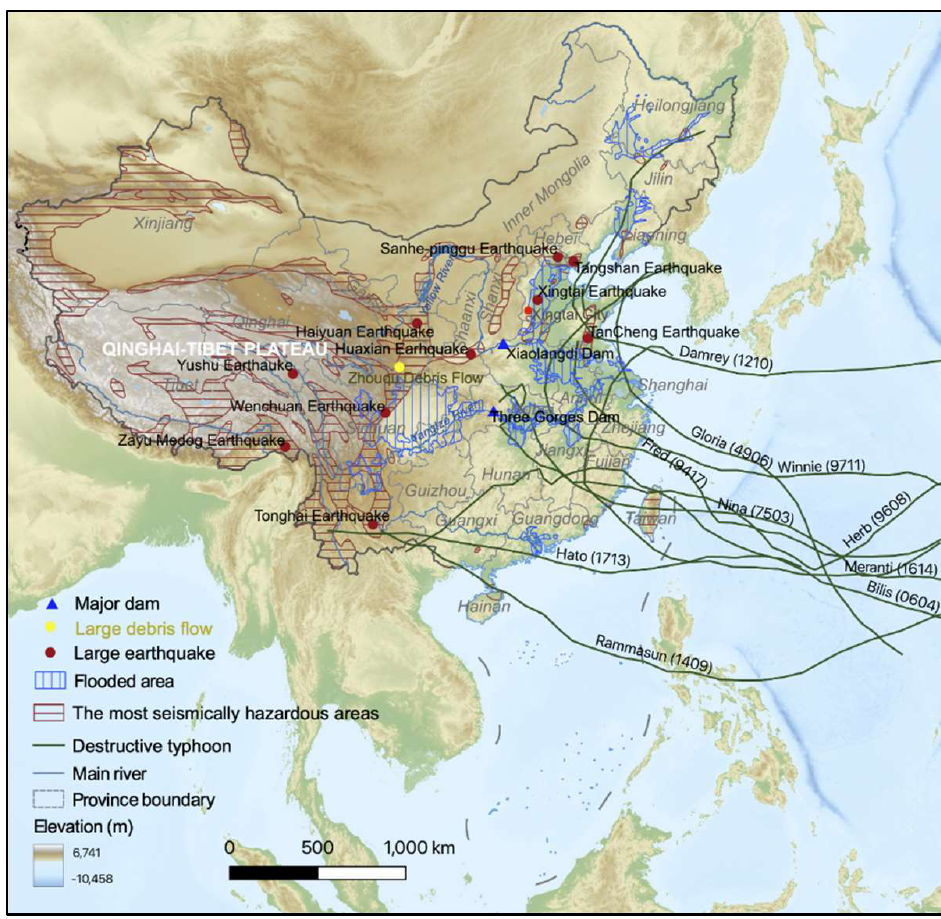
Figure 1. China’s geographical location and topography as well as the spatial distribution of major natural disaster events in China from 1950 to 2020 (historical flooded area data is from ref. [11]). Furthermore, rapid socioeconomic growth and urban sprawl have significantly changed both the exposure and vulnerability dimensions of flood risk in China [12–14]. From 1978 to 2019, China’s GDP and population increased 39-fold and nearly 50%, respectively. China’s GDP per capita increased from 156.4 US$ in 1978 to 10,216.60 US$ in 2019. From the per- spective of spatial distribution, approximately 94.4% of China’s population live in the area east of Hu Line (about 42.9% of China’s land area) [15]. On the other hand, land use/land cover (LULC) changes brought by mass urbanization have caused many people and assets to be exposed to flood risks